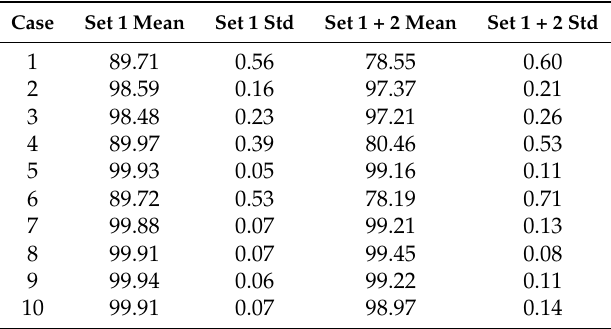
Table 4. Extensive experimentation